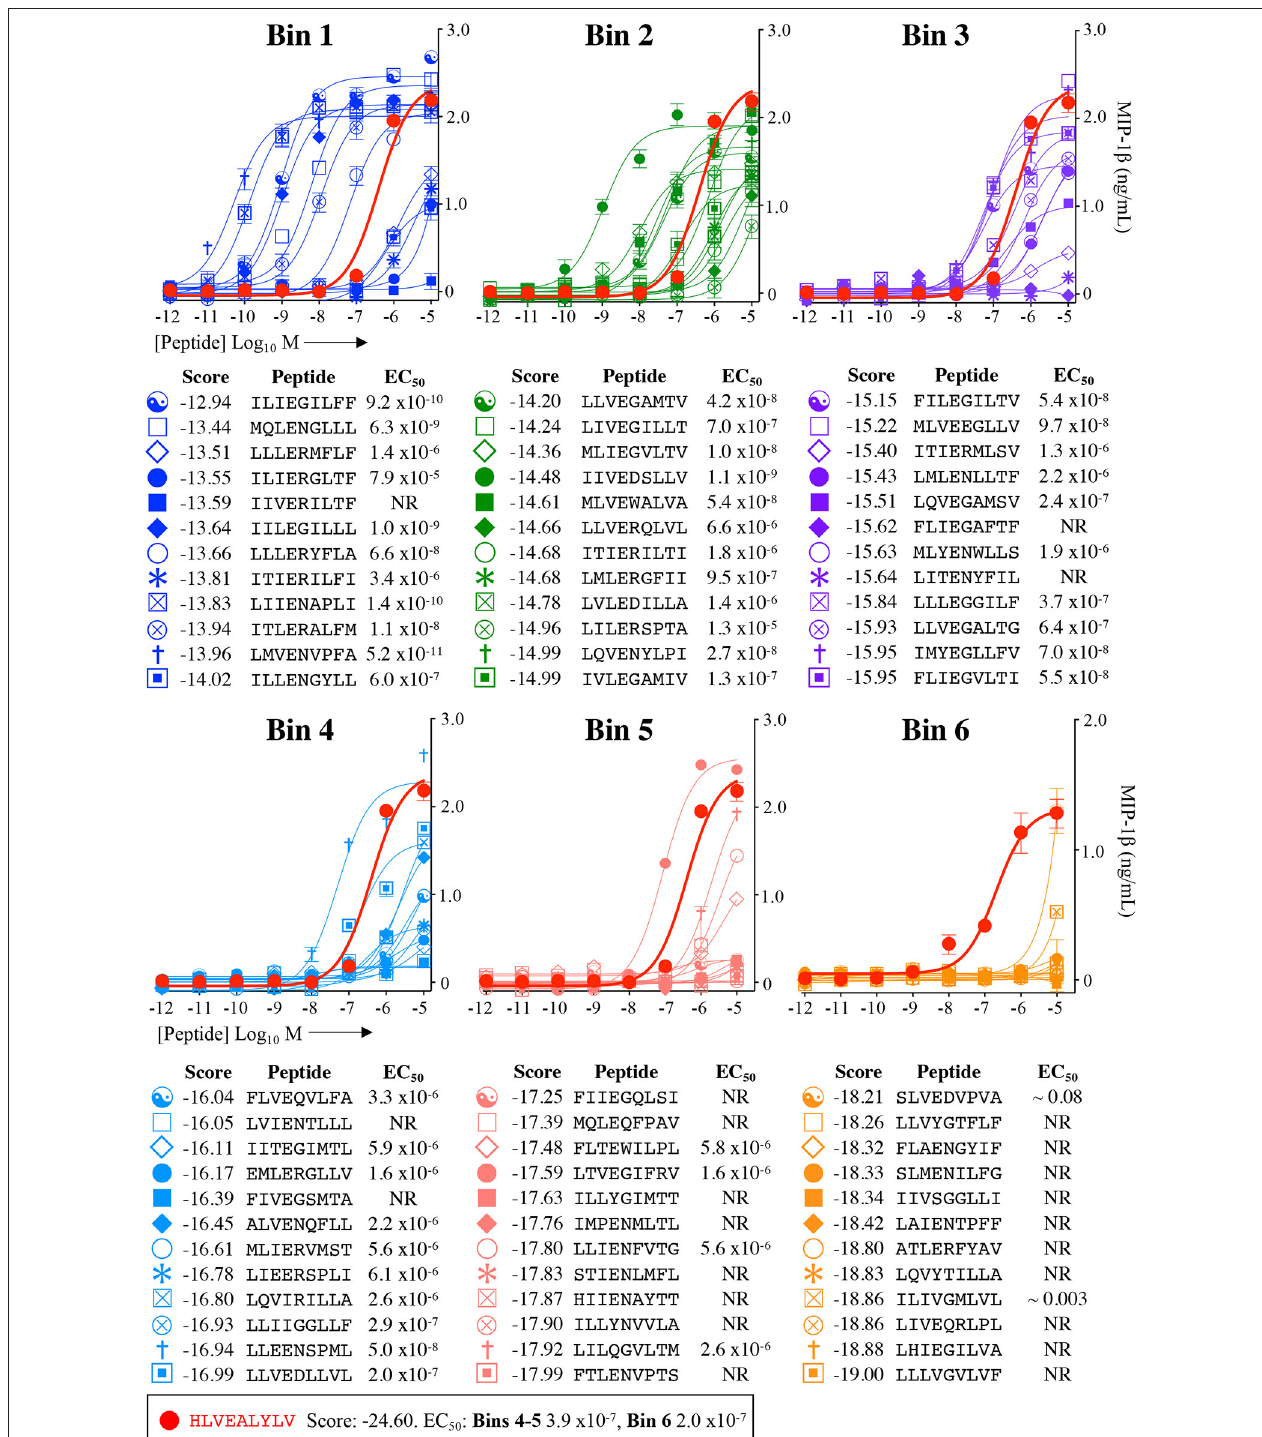
FIGURE 5 | Recognition of 72 randomly chosen and uniformly distributed fungal peptides by the InsB4 T-cell clone. Each panel shows results of MIP-1 β assay, indicating activation of T-cell clone InsB4 by 12 peptides and the index HLVEALYLV peptide (shown as a bold red line). InsB4 was incubated overnight with the indicated peptides and MIP-1 β released into the supernatants quantified by ELISA. Bins 1–5 were performed in the same assay with Bin 6 performed in a separate experiment hence the different EC 50 values for the index peptide. EC 50 for each peptide (M) is displayed in the tables. NR, no T-cell response. The mean p EC 50 for each bin is plotted in Figure 7A